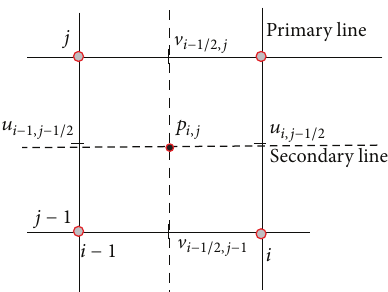
Figure 2: Staggered grids of MAC